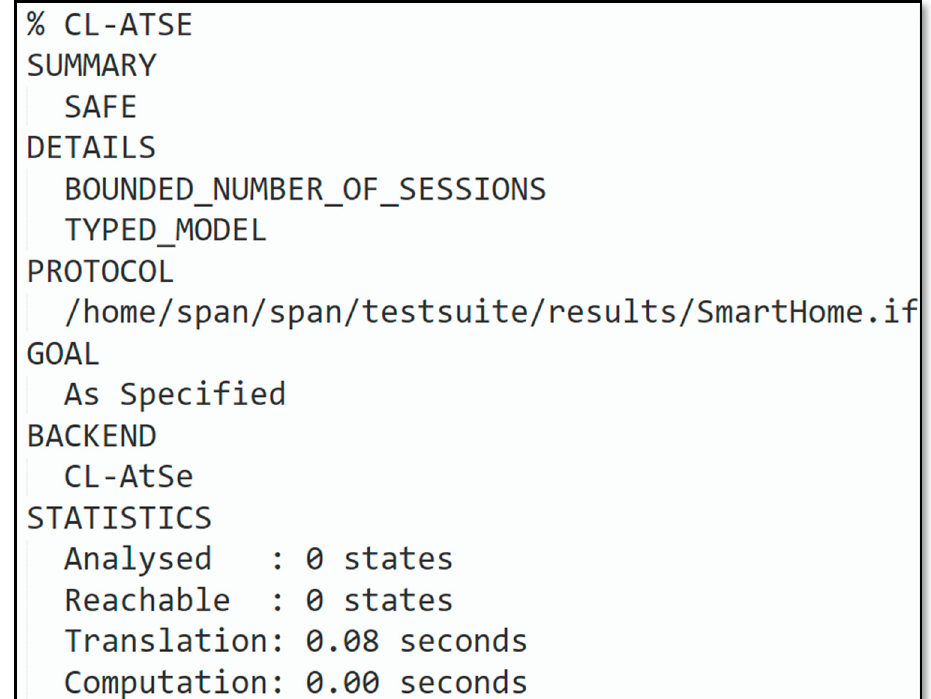
Figure 9. CL-AtSe backend analysis.